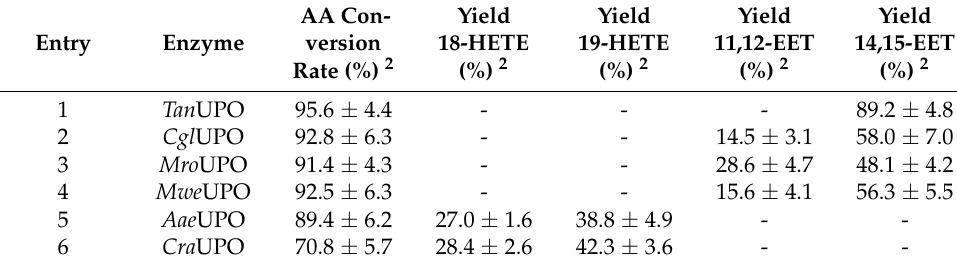
Table 1. Screening of different UPOs for the oxyfunctionalization of AA 1 .